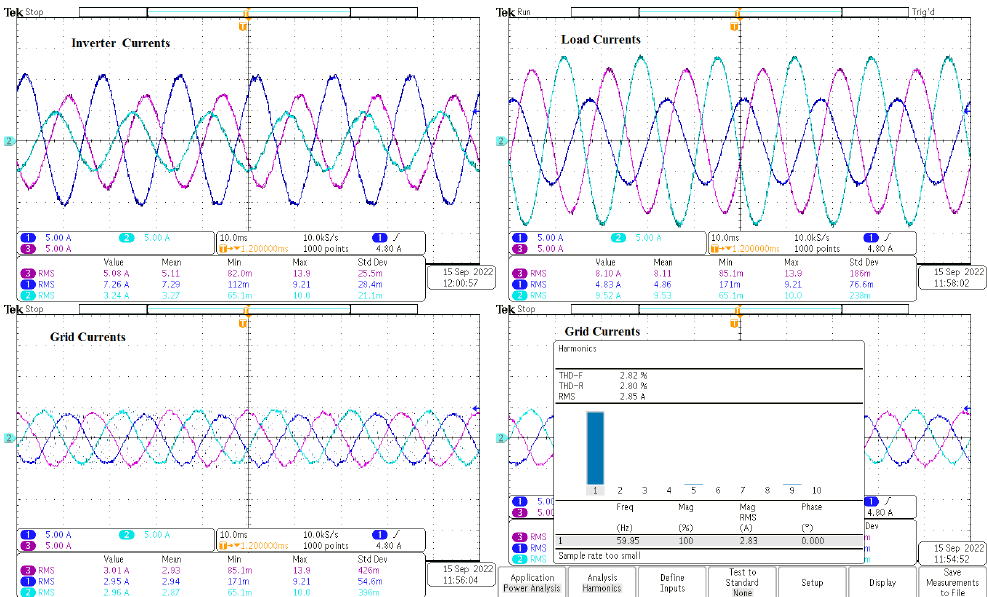
Figure 23. Hardware results using Tektronix MDO3024 oscilloscope for real power = − 1 kW and reactive power = 0.5 kvar under balanced grid inductances.